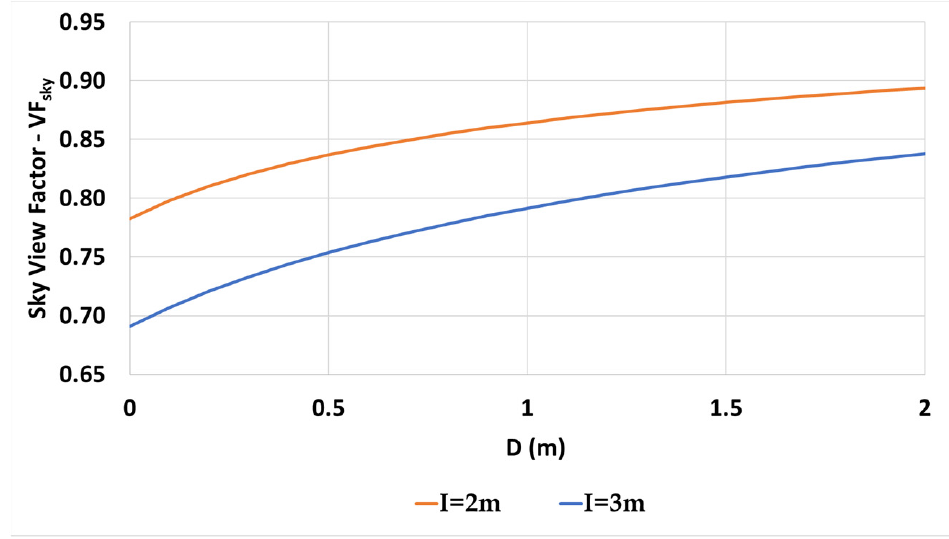
Figure 23. Variation of sky view factor of collector with distance from a convex roof-collector facing a convex roof.